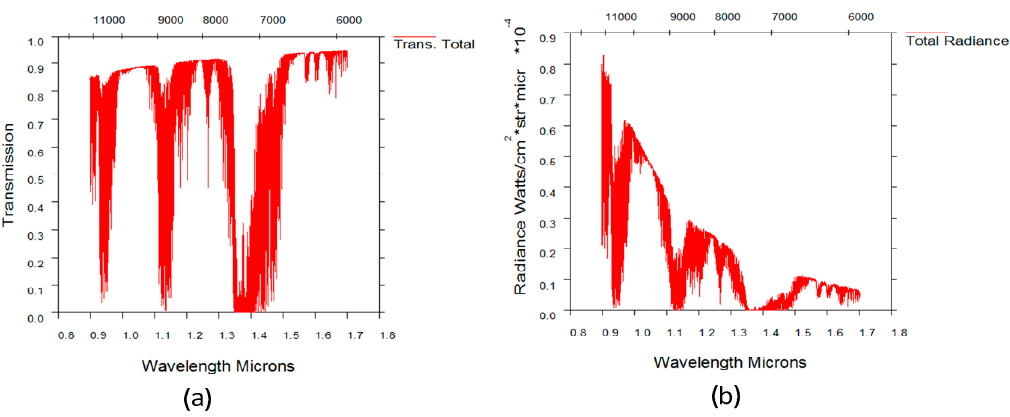
Figure 14. SZA = 89.43°, VZA = 35.3°, SAA = 174.2°. ( a ) Atmospheric transmittance, ( b ) atmospheric background radiation intensity.